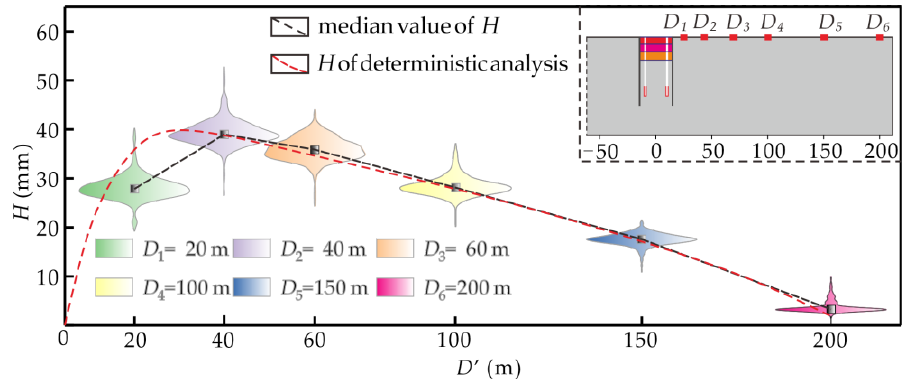
Figure 12. Violin plot of settlements of all the realizations at various locations.